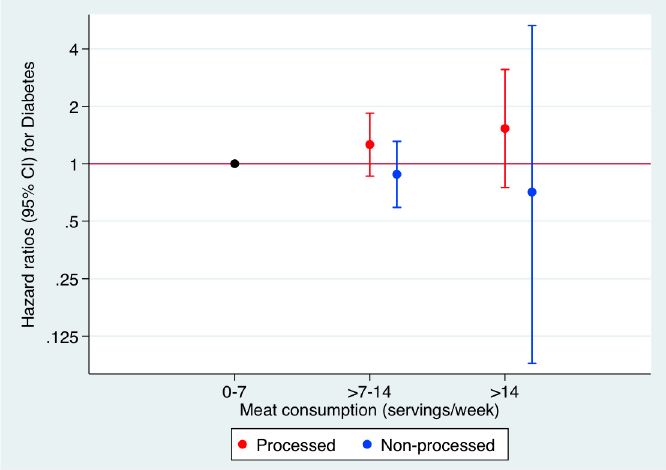
Fig 2. HR for incident type 2 diabetes according to categories of weekly processed and non- processed meat consumption. The SUN Project 1999 –